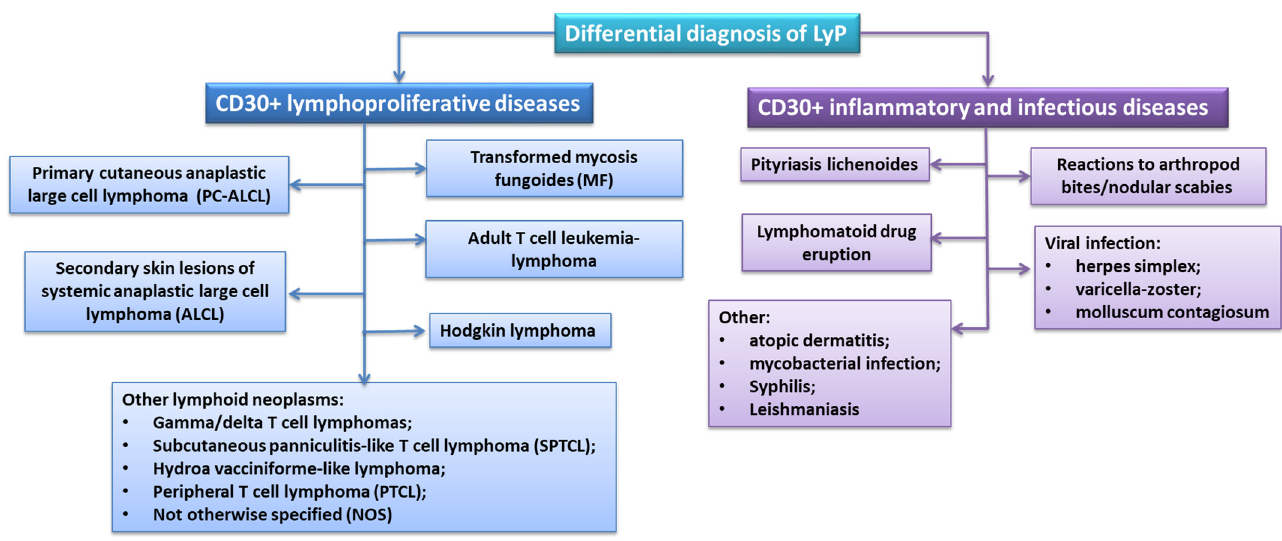
Figure 3. Differential diagnosis of LyP.